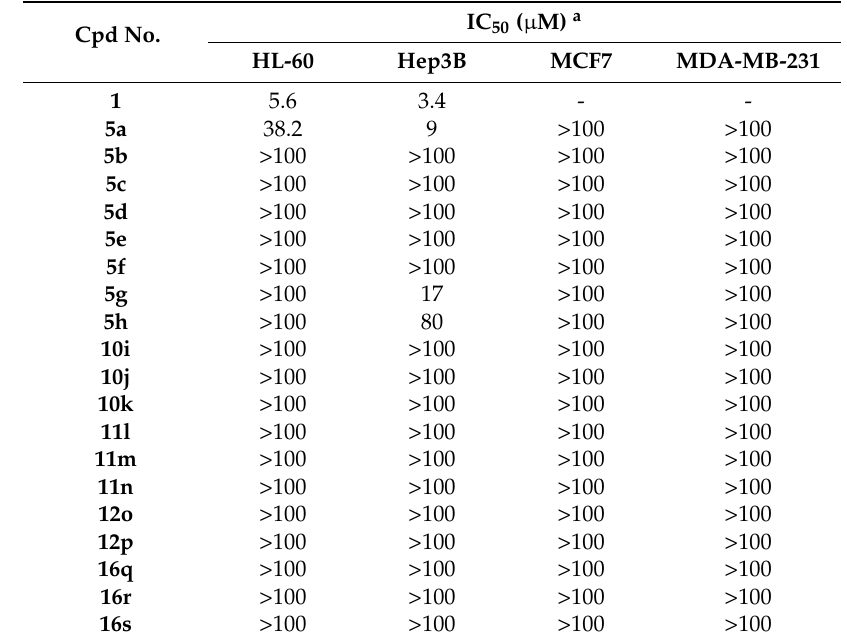
Table 2. Cytotoxicity effect of 1 , cantharidin-sulfanilamides ( 5a – h ), and imide analogues ( 10i – k , 11l – n , 12o – p , and 16q – s ) in human hepatocellular carcinoma (Hep3B), myeloid leukemia (HL-60), and human breast adenocarcinoma (MCF7 and MDA-MB-231) cell